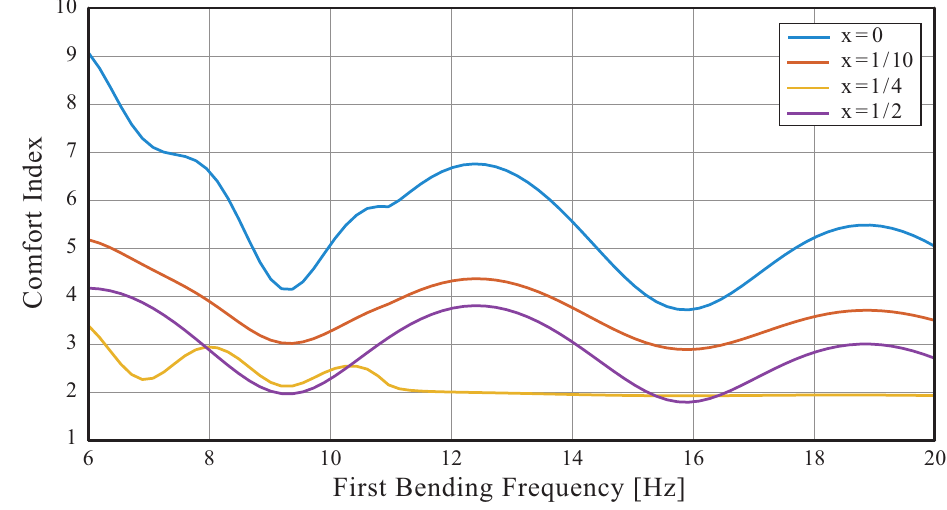
Figure 8. Comfort index at four locations on the beam versus the first bending frequency ( f 3